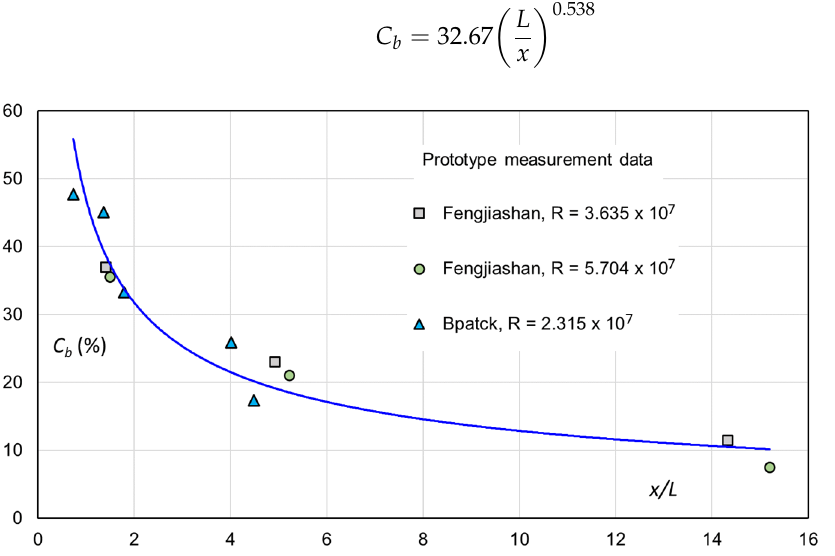
Figure 18. Prototype measurement results from the Fengjiashan and Bpatck aerators, streamwise change of bottom air concentration C b downstream of the impact location (based on the data in [12]).